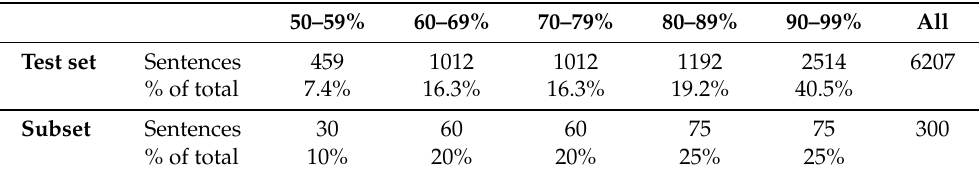
Table 1. Number of sentences in the test set and the subset used for manual evaluation per fuzzy match